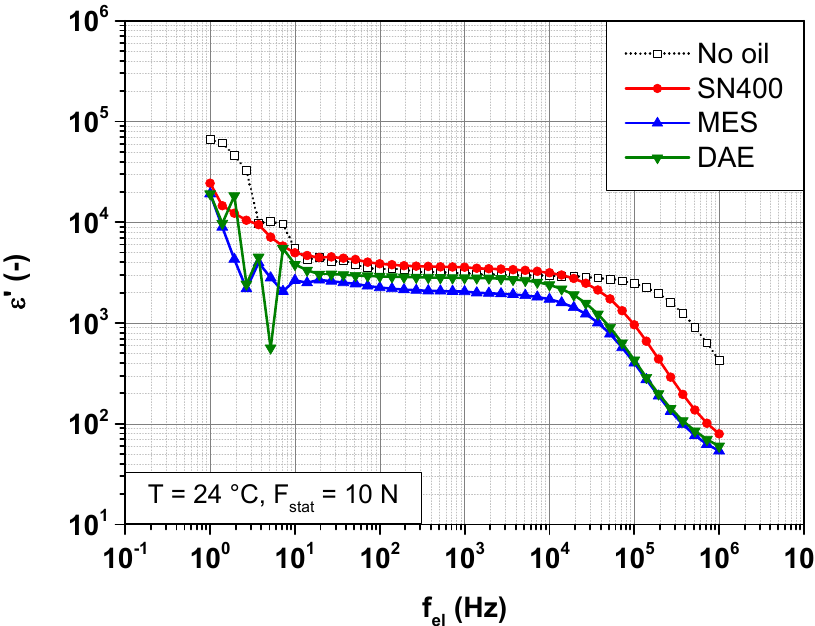
Figure 6. Frequency ‐ dependent change in the real part of the permittivity 𝜀 (cid:4593) of SBR samples with different plasticizers at 24 °C under a static force of 10 N.